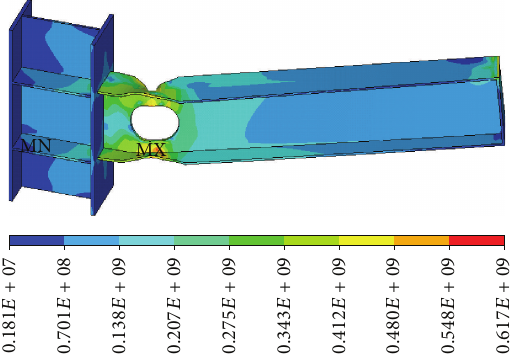
Figure 8: Stress of beam weakened connection.